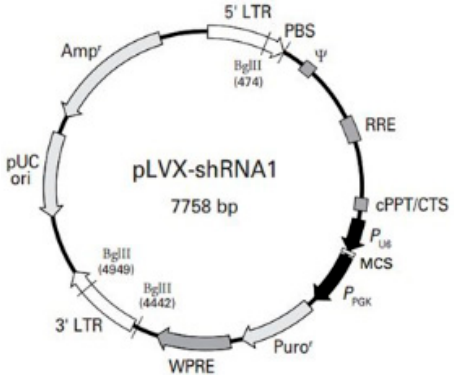
Figure 1. The vector map of shRNA designed to knockdown PTP4A3.